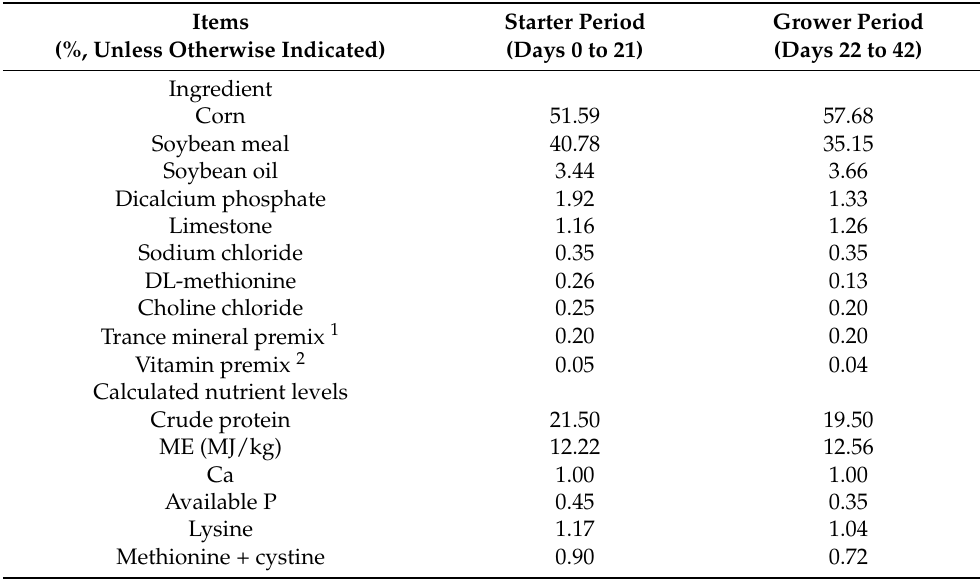
Table 1. The feed ingredient composition and nutrient levels, on an air-dried